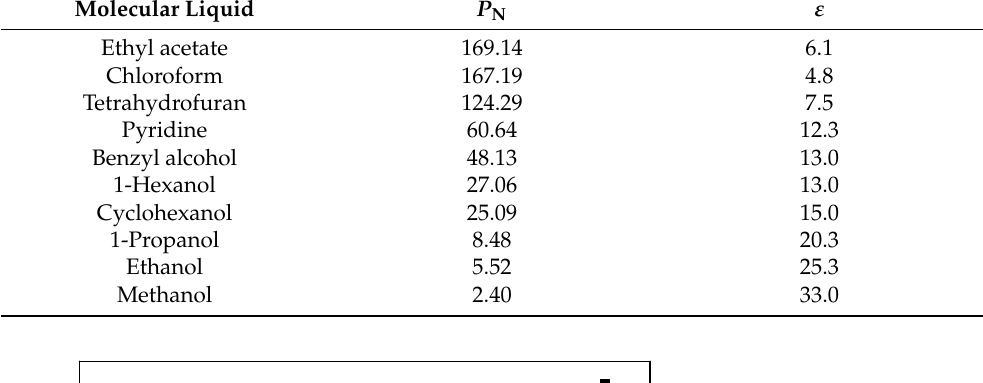
Table 7. P N and dielectric constant ( ε ) of various molecular liquids.